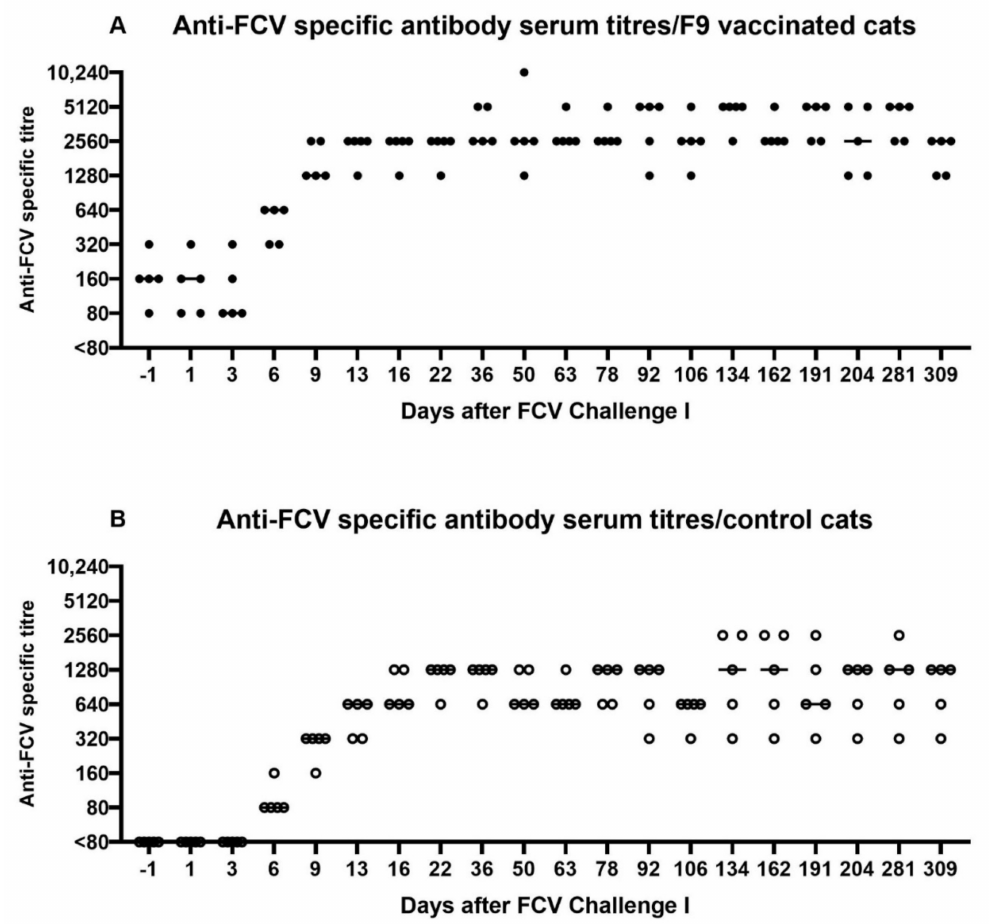
Figure 6. Dot plots of anti-FCV specific antibody serum titres measured by IFA before and after FCV Challenge I in the vaccinated cats ( A ) and control cats ( B ). Antibody titres reflect the reciprocal of the last serum dilution showing positive fluorescence in the IFA. Each dot represents the titre of a cat of the vaccine or control group, respectively. The horizontal bar represents the median. Table 2. Endpoint neutralisation titres of cats of the vaccine and the control group, respectively. The titre is the reciprocal of the serum dilution where 50% or more of the wells show a